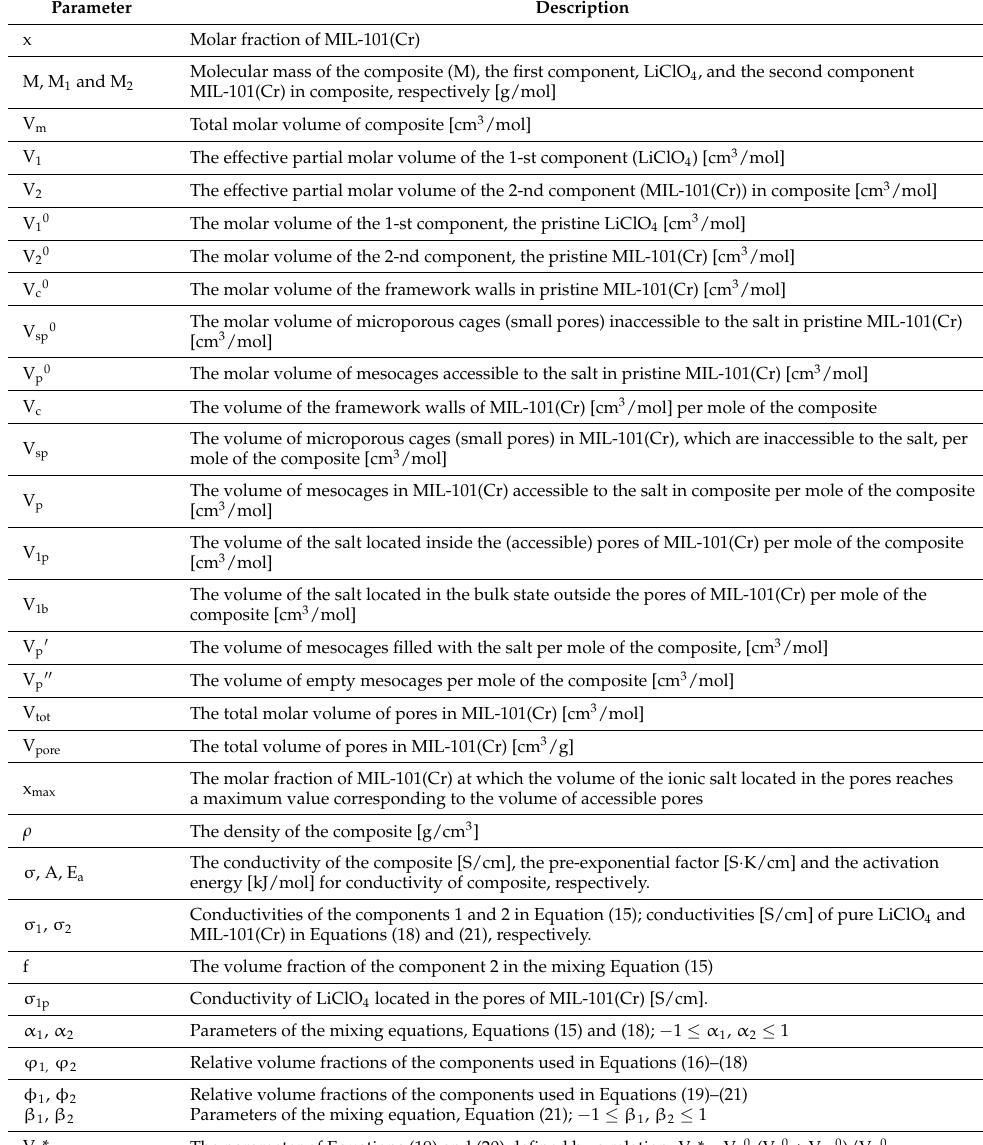
Table A1. List of variables and designations used in the